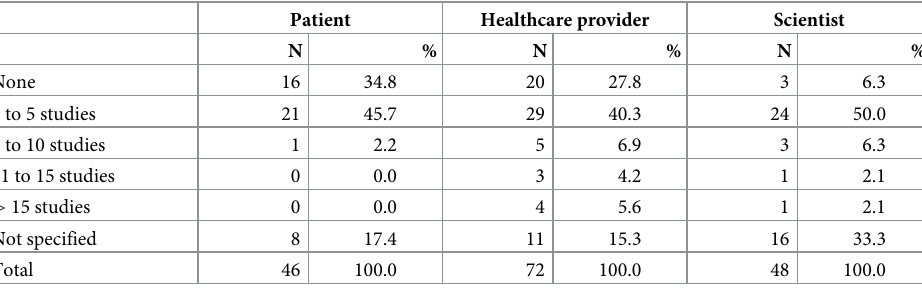
Table 2. Engagement of the respondents in medical research (in number of studies) a